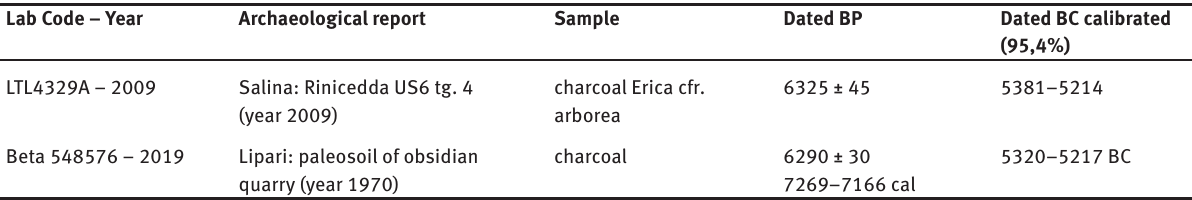
Table 2: Neolithic sites of the Stentinello facies and radiocarbon dating. Lab Code –